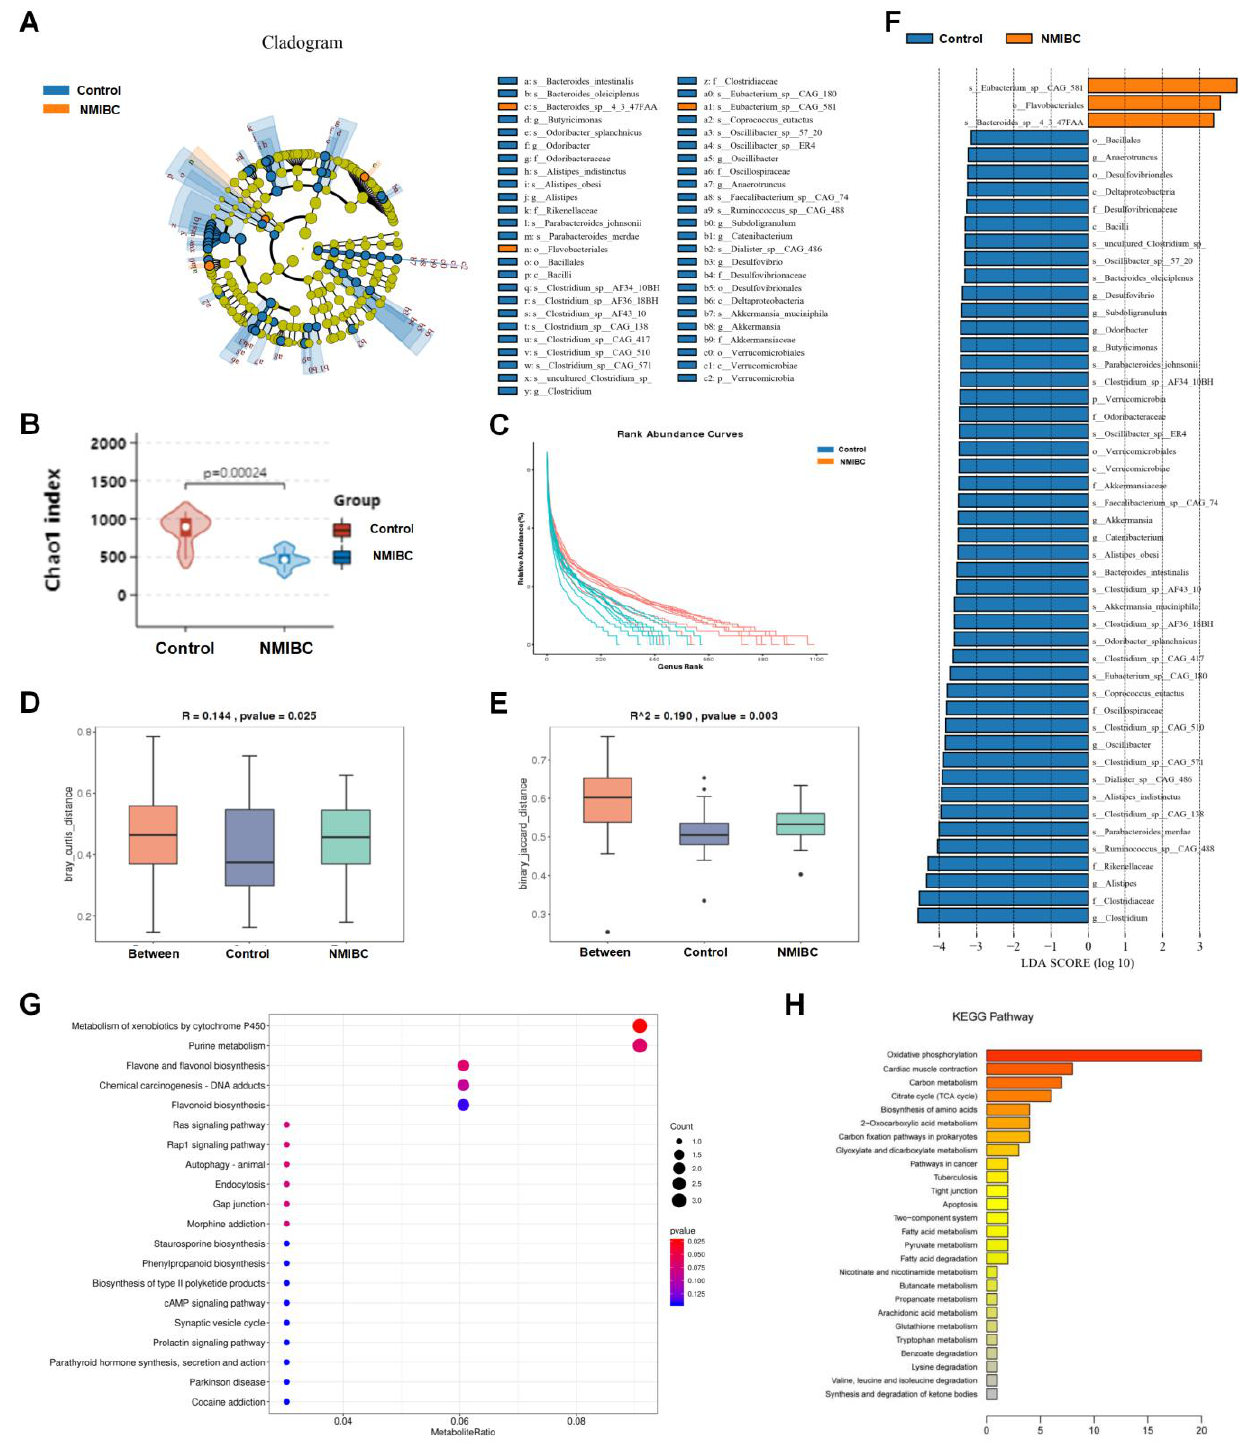
Figure 1. Metagenomics data manifested the clinical association between Eubacterium sp. CAG:581 and NMIBC occurrence. ( A ) A cladogram representation of data in 51 NMIBC patients versus 47 healthy controls by 16S rDNA sequencing; taxa enriched in NMIBC patients (amber) and healthy controls (cobalt). The brightness of each dot is proportional to its effect size. ( B , C ) Chao 1 richness index ( B ) and rank abundance curves (C) of urine samples from 51 NMIBC patients (amber) versus 47 healthy controls (cobalt). ( D , E ) Bray–Curtis’s distance ( D ) and binary Jaccard distance ( E ) of urine samples from 51 NMIBC patients (amber) versus 47 healthy controls (cobalt). ( F ) Linear